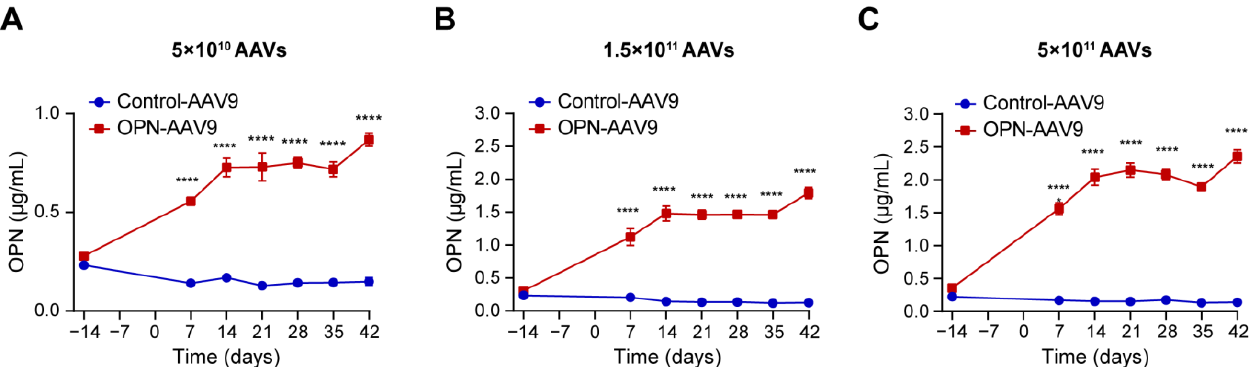
Figure 1. Transduction with OPN-expressing AAV9 increases cOPN levels. ( A – C ) C57BL/6 mice were injected i.v. with empty adeno-associated viral vector (Control-AAV9) or osteopontin-express- ing adenoviral vectors (OPN-AAV9) at titres of 5 × 10 10 ( A ), 1.5 × 10 11 ( B ) and 5 × 10 11 ( C ) viral parti- cles per mouse at day 0. Blood was collected from the animals 14 days before virus injection to determine pre-transduction levels, as well as at 7-day intervals following AAV-mediated transduc- tion. OPN levels in the plasma were determined by ELISA. Groups were compared using repeated measures two- way ANOVA with Šídák’ s multiple comparisons tests; n = 4 for all groups. **** p <